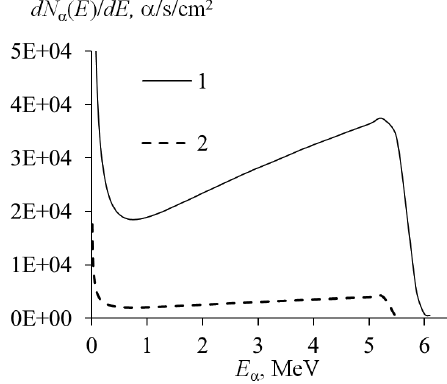
Figure 5. Spectrum of alpha particles escaping from the kernel sur- face at a solid angle of 4p (1 – irradiated fuel; 2 – unirradiated